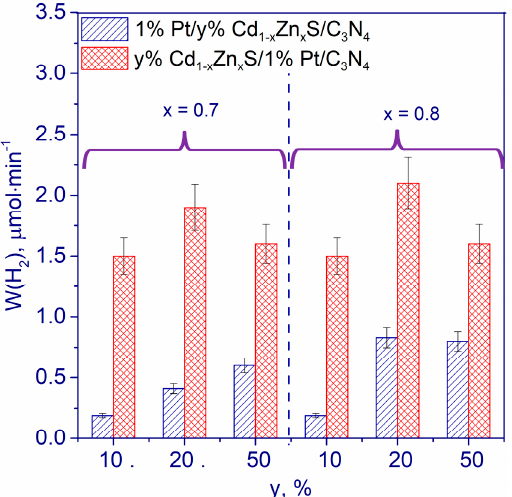
Figure 9. Photocatalytic activity of samples 1%Pt/y%Cd 1 − x Zn x S/g-C 3 N 4 and y%Cd 1 − x Zn x S/1% Pt/g-C 3 N 4 . Adapted from [104].